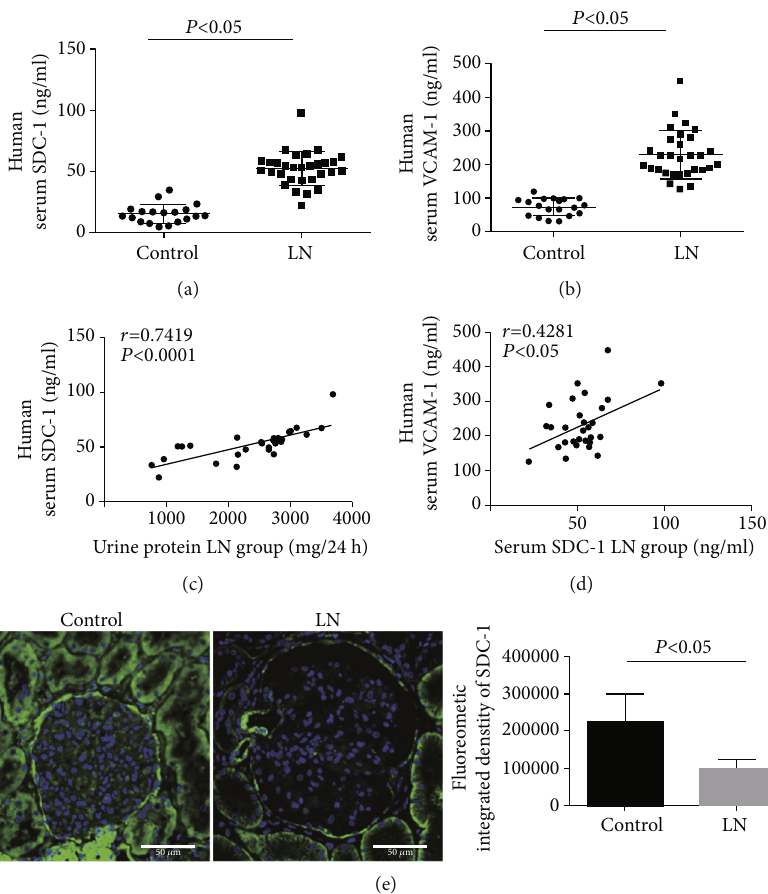
Figure 1: The level of SDC-1 was associated with the levels of VCAM-1 and proteinuria in LN patients. (a, b) ELISA showing the levels of serum SDC-1 and VCAM-1 in the control and LN patients. (c, d) The level of serum SDC-1 in LN patients was correlated with 24 h proteinuria ( r = 0 : 7419 , p < 0 : 0001 ) and serum VCAM-1 ( r = 0 : 4281 , p < 0 : 05 ). (e) The expression of SDC-1 protein in renal glomeruli cells of LN patients was detected by IF staining. SDC-1: syndecan-1; VCAM-1: vascular cell adhesion molecule-1; ELISA: enzyme-linked immunosorbent assay; IF: immuno fl uorescence; LN: lupus